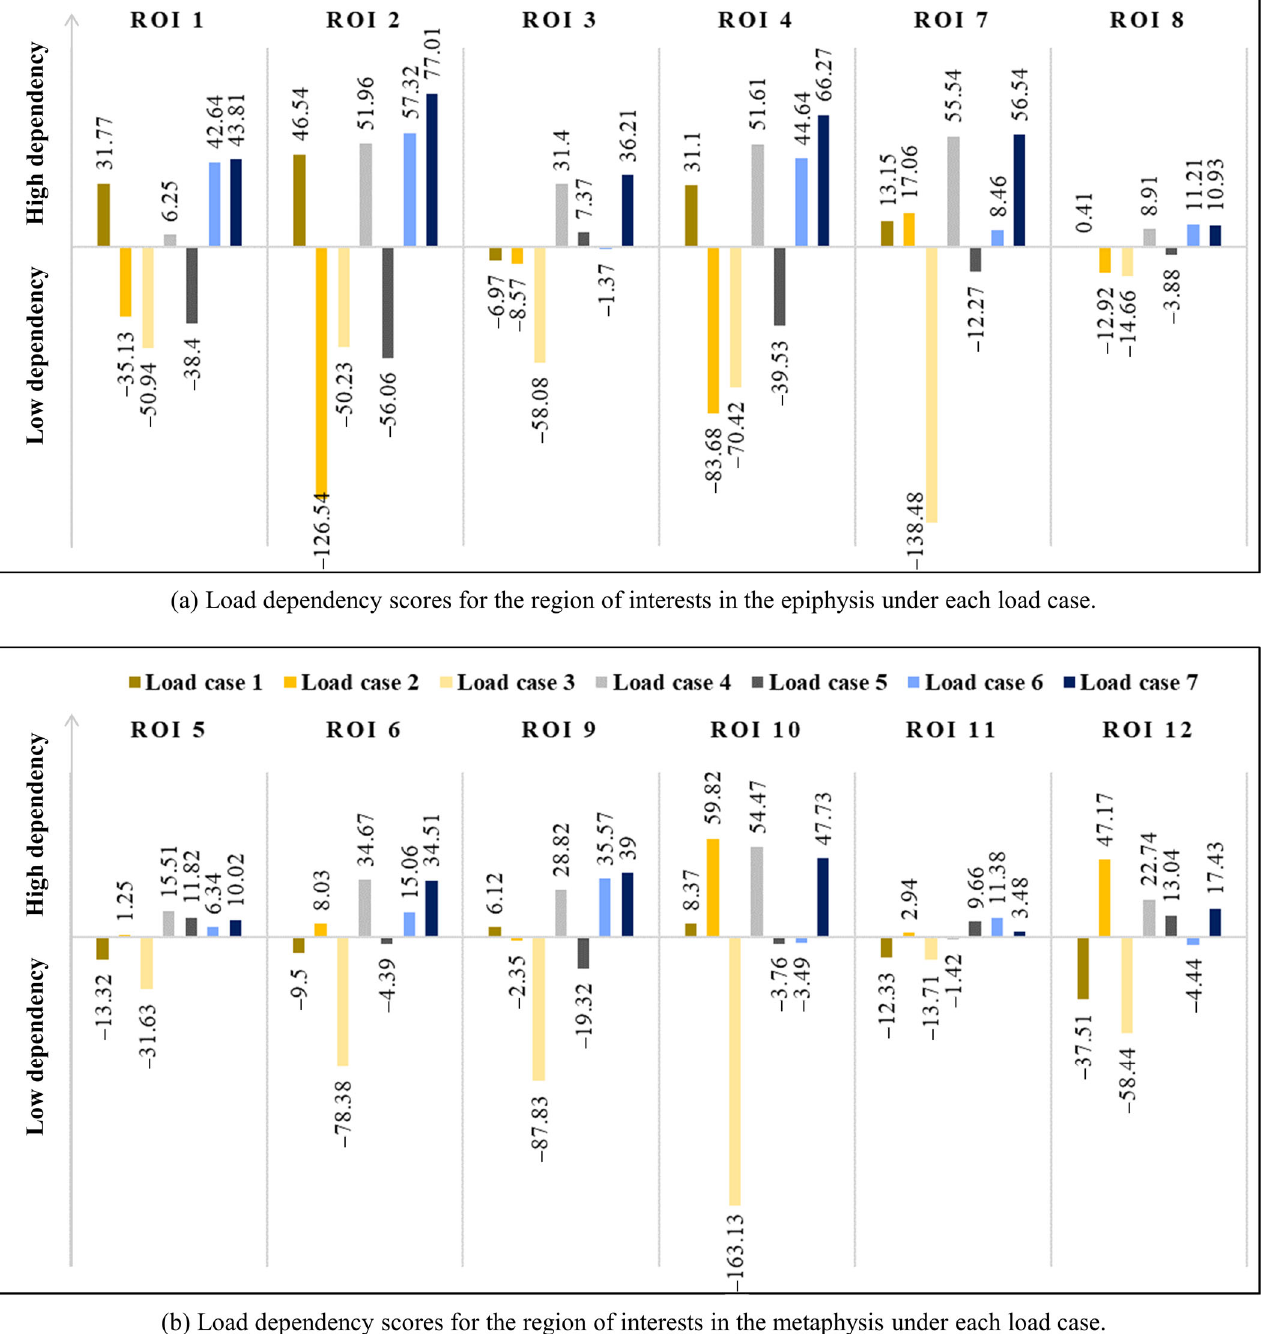
Figure 4. Load dependency scores for the region of interests under each load case. ( a ) Load de- pendency scores for the region of interests in the epiphysis under each load case, and ( b ) Load dependency scores for the region of interests in the metaphysis under each load case.